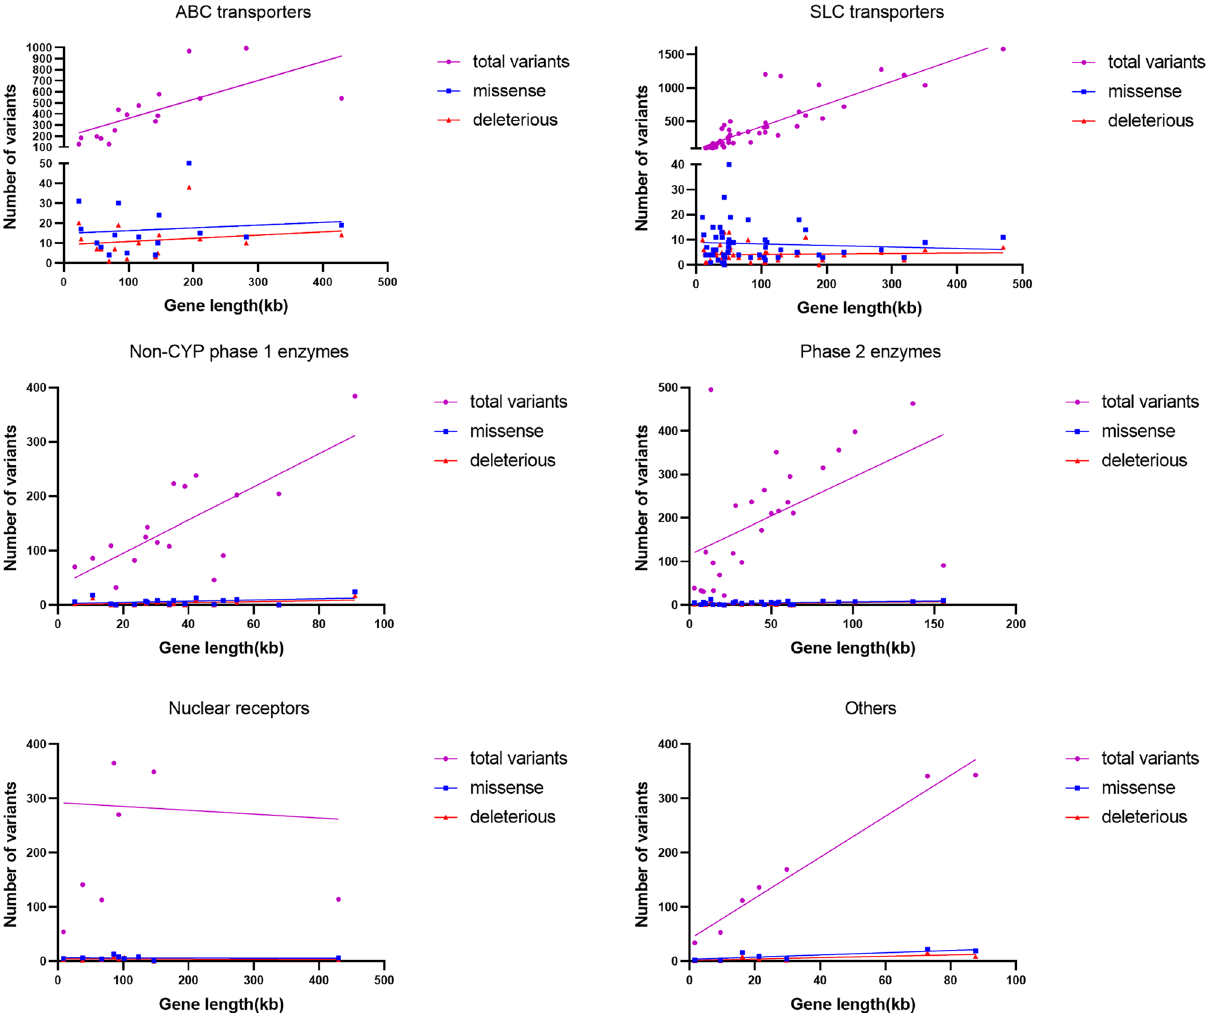
Figure 5. Correlation of variants number with the gene length. The relationship between the number of total variants, missense variants and deleterious variants and the corresponding gene length among the 6 pharmacogenes groups were